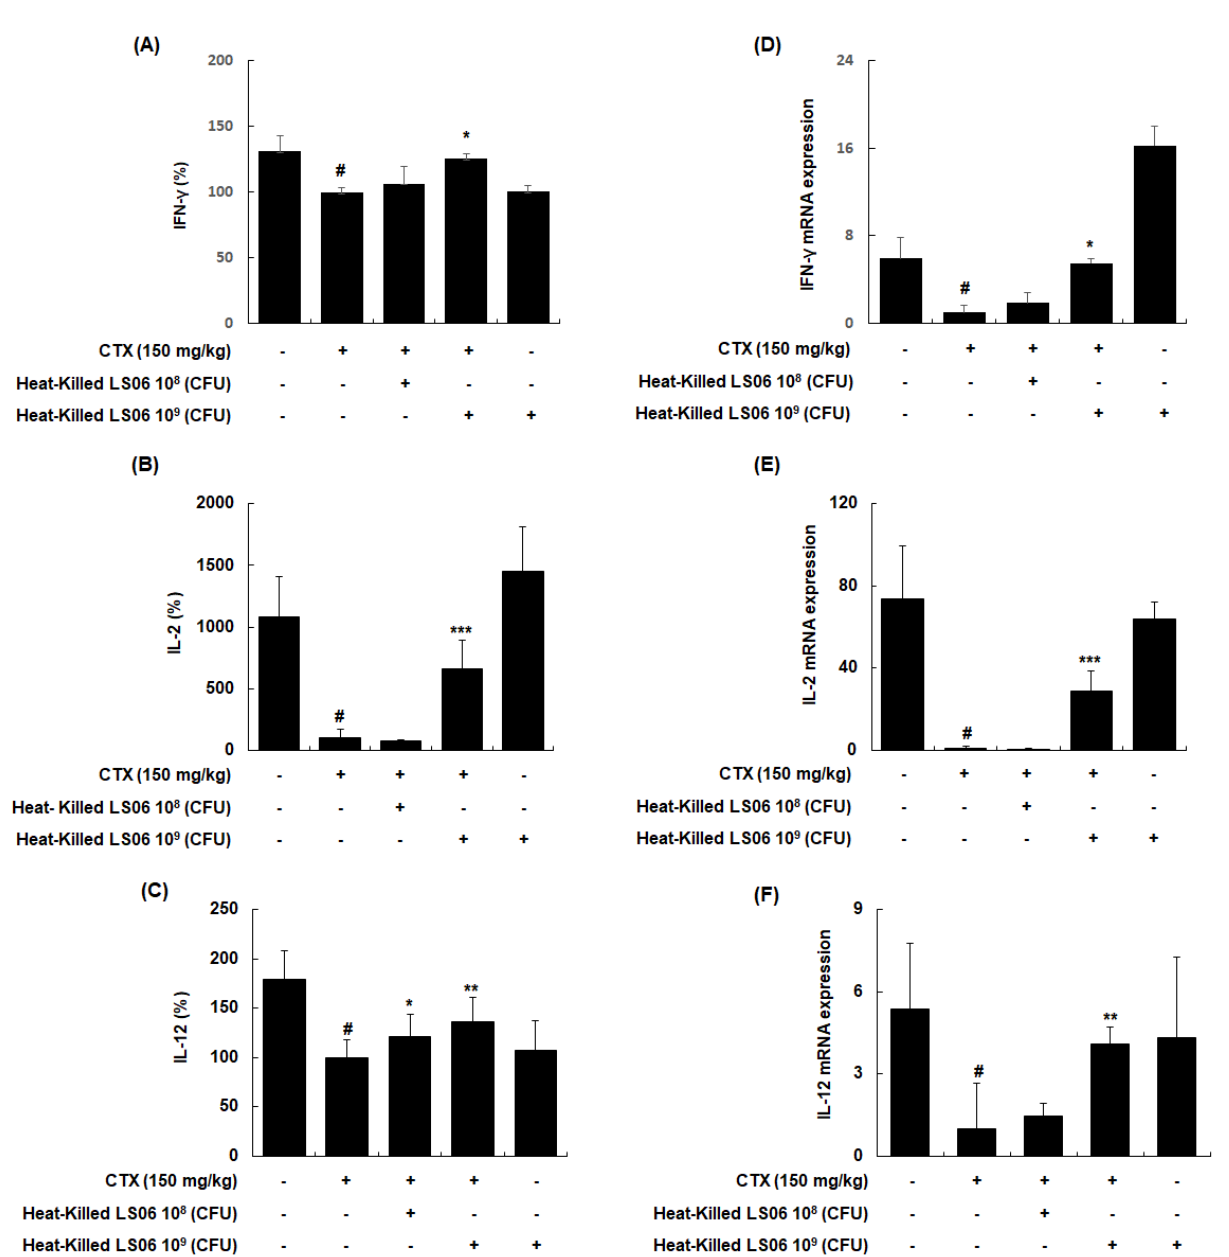
Figure 7. Effects of heat-killed LS06 on the expression level of Th1-related cytokines production and mRNA in splenocytes isolated from CTX-treated mice. ( A – C ) The production and ( D – F ) mRNA expression levels of the Th1-related cytokines. Data are presented as mean ± SEM ( n = 10). # p < 0.05 vs. Con group; * p < 0.05, ** p < 0.01, and *** p < 0.001 vs. CTX group.